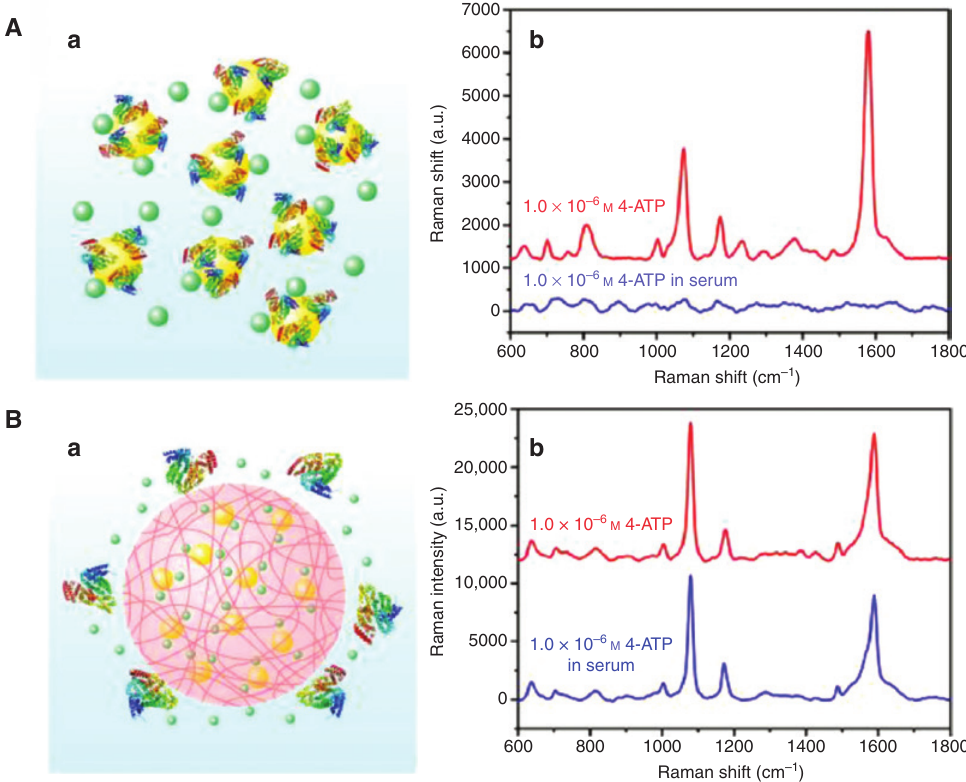
Figure 4: Depiction of the protein problem in SERS measurements and possible solutions. (A, a) The nonspecific adsorption of proteins on Au NPs leads to “protein coronas” which block the analyte (e.g. drug) from entering the hot spots close to the NPs surface. (A, b) SERS measurements with colloidal gold: while the spectrum of 1.0 × 10 −6 4-aminothiopheno (4-ATP) in aqueous solution (red) shows pronounced peaks, the spectrum for 1.0 × 10 −6 m 4-ATP in serum (blue) has no characteristic features due to the protein problem. (B, a) Semipermeable microparticles prevent the diffusion of proteins but allow the diffusion of small molecules. The hot spots remain accessible, and the protein problem is avoided. (B, b) SERS measurements with colloidal gold within semipermeable microparticles: The spectra of 1.0 × 10 −6 m 4-ATP in water and in serum both show strong characteristic features. Adapted from Yue et